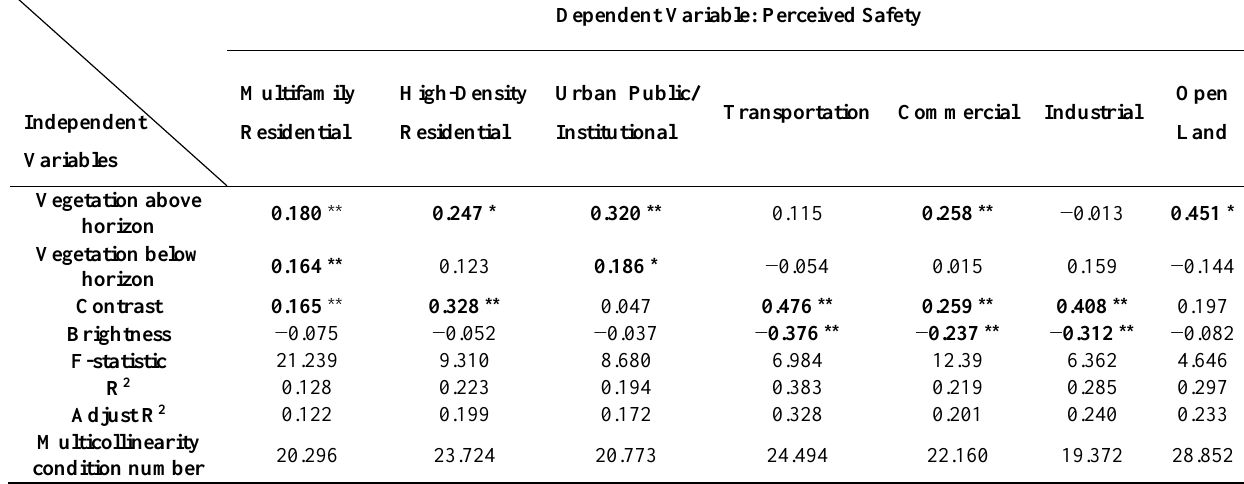
Table 4. Multivariate linear regression coefficients of vegetation above the horizon, vegetation below the horizon, contrast and brightness against perceived safety for different land use types. Standardized coefficients (betas) are reported